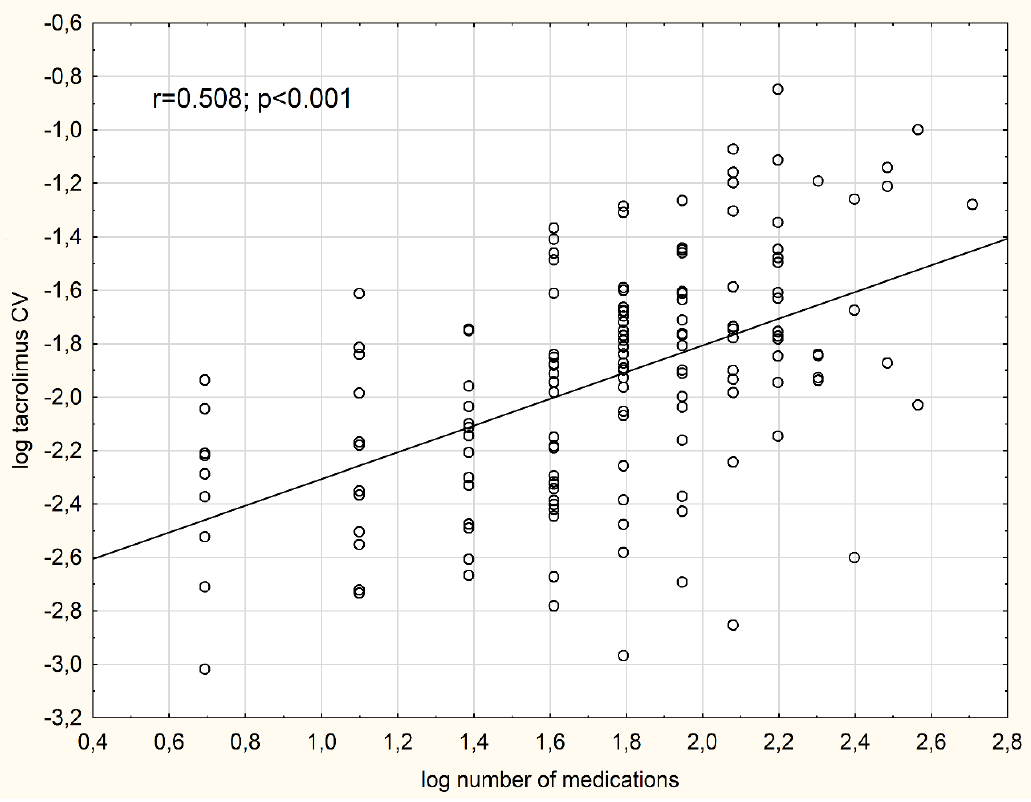
Figure 2. The association between the logarithmized values of tacrolimus CV and the logarithmized number of medications.